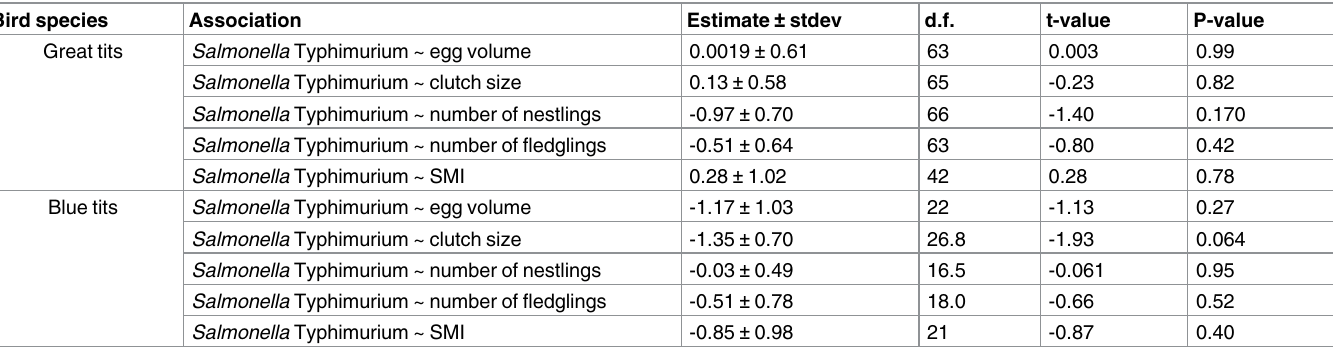
Table 4. Statistical analysis. We investigatedthe association betweenthe presence of Salmonella Typhimurium on the eggshellof blue and great tits and the egg volume, clutch size, number of nestlings,number of fledglingsand SMI. The results are represented as the estimate ± standarddeviation(stdev), degreesof freedom (d.f.), t-value and